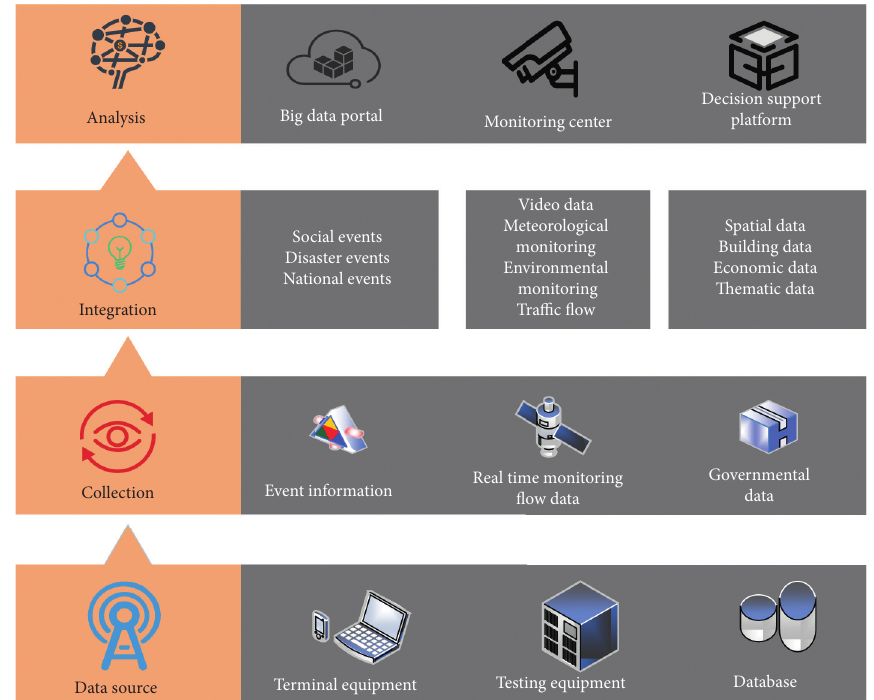
Figure 4: Management of the whole data life cycle of smart city.